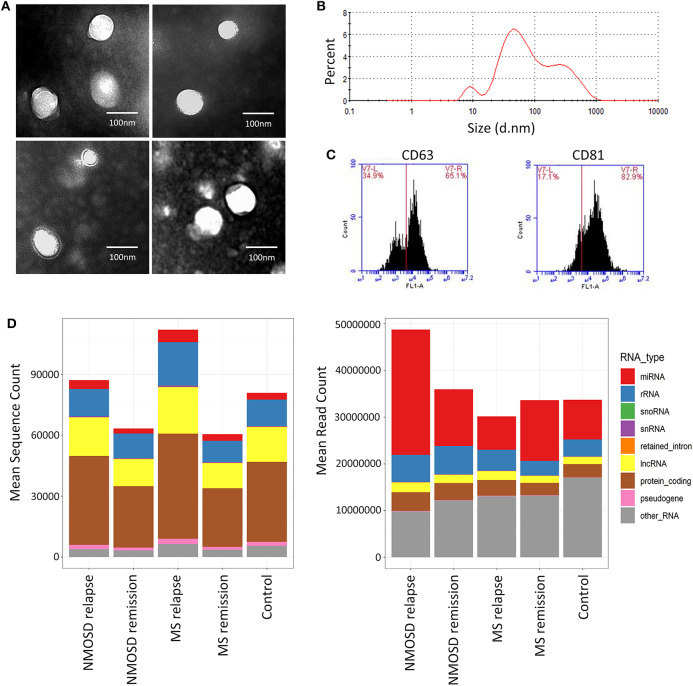
Analysis of serum exosomal miRNAs in NMOSD, MS and HCs by next-generation sequencing. (A) Transmission electron microscopy images of extracted serum exosome. The diameter of typical exosome is <100 nm. (B) The representative result of nanoparticle tracking analysis. (C) Two exosomal markers (CD63 and CD81) detected by flow cytometry. (D) The mean sequencing count and the mean read count per sample of different classes of RNA in NMOSD, MS, and HCs.